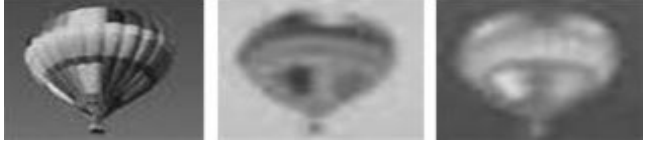
Figure 6. Luminance/chrominance (YcbCr) components of the patch. Application of Level 1 Haar’s DWT resulted in four sub-bands (LL, HL, LH and HH)